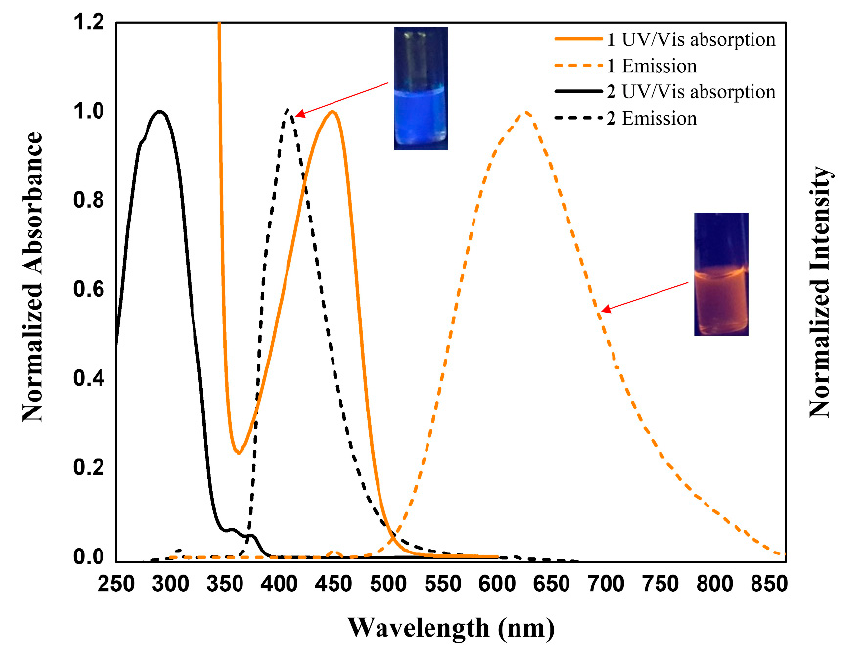
Figure 9. UV/Vis absorption and fluorescence spectra of 1 and 2 recorded in CH 3 CN.